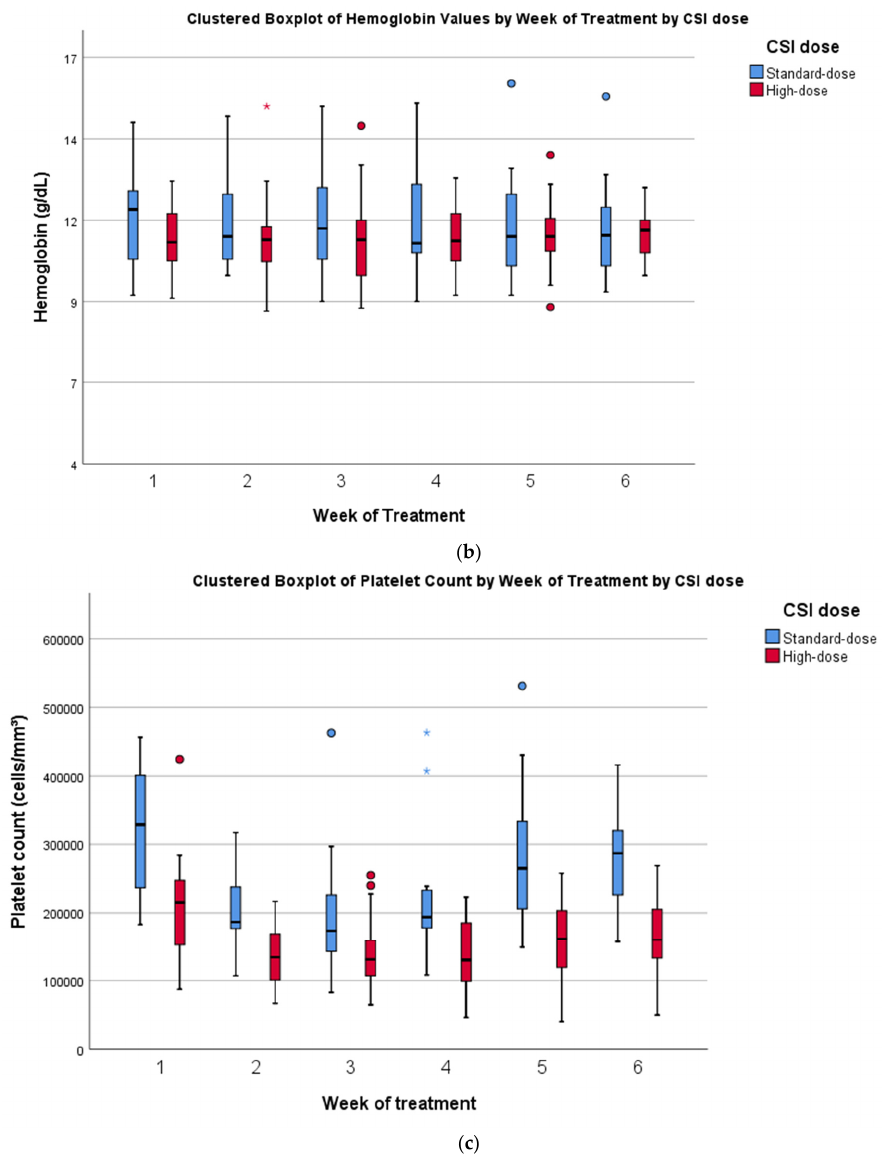
Figure 1. Trends in hematological variables during PT. Clustered boxplots by week of treatment for standard-dose and high-dose CSI: ( a ) leukocyte count (cells/mm³); ( b ) hemoglobin (g/dL); ( c ) platelet count (cells/mm³). Asterisks (blue for standard-dose, red for high-dose) represent extreme outliers.